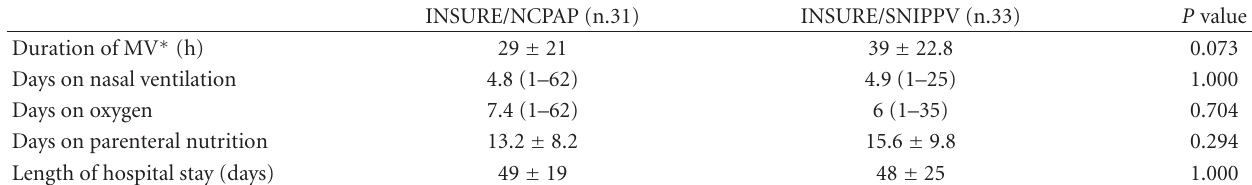
Table 3: NICU course in the two study